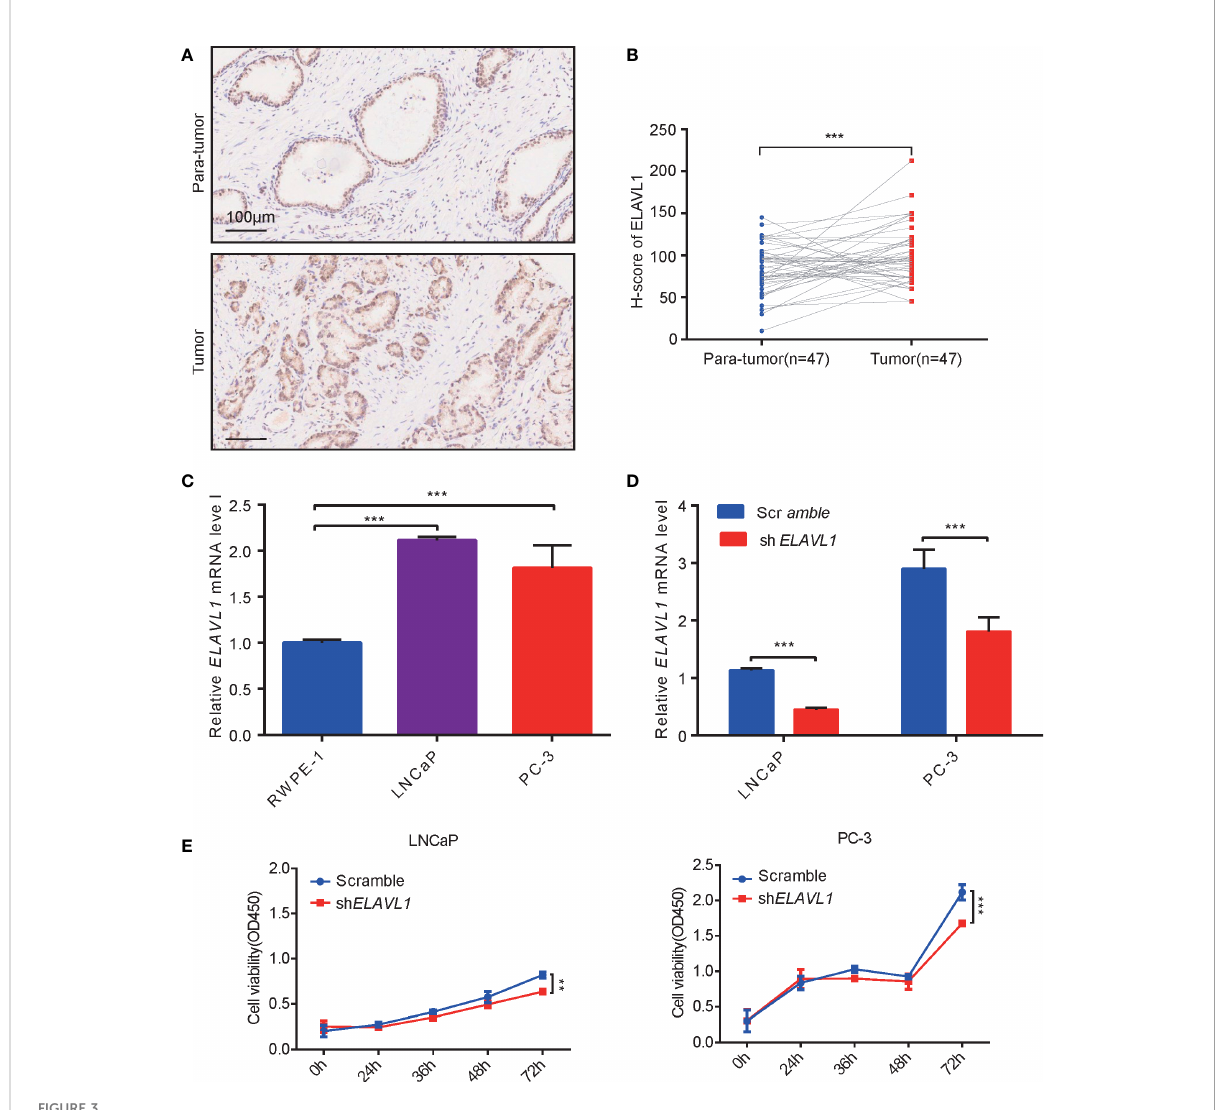
FIGURE 3 ELAVL1 promoted prostate cancer growth. (A) Immunohistochemistry for ELAVL1 expression in samples of prostate cancer; (B) H-score of ELAVL1 for immunohistochemistry of prostate cancer samples; (C) ELAVL1 expression in cell lines of prostate cancer; (D) RT – qPCR for ELAVL1 knockdown in prostate cancer cells; (E) CCK-8 for detecting prostate cancer proliferation after ELAVL1 knockdown. **p < 0.01, ***p <